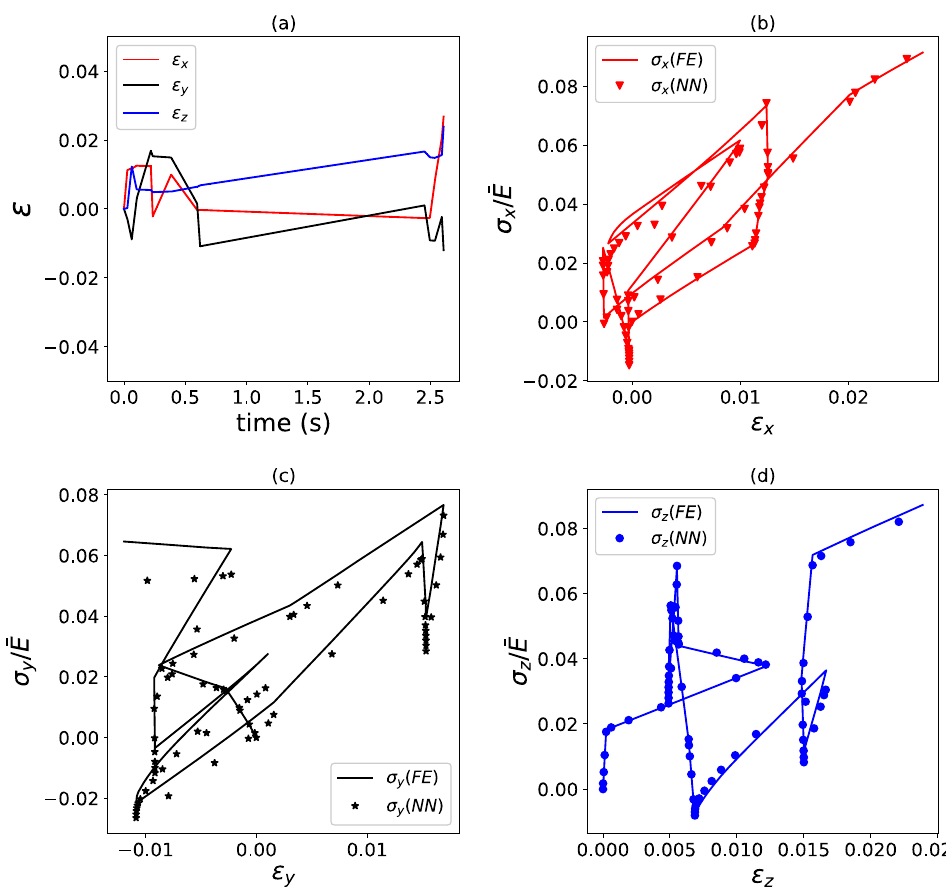
Figure 7. Example of strain versus time ( a ) and stress versus strain ( b – d ) histories for a viscoelastic composite with κ = 2.0 and stiffness relaxation dictated by a three-term Prony series. FE predictions are compared to predictions by a surrogate model. E σ = 19.4% for the load case shown, which used φ = 5000 training data points.